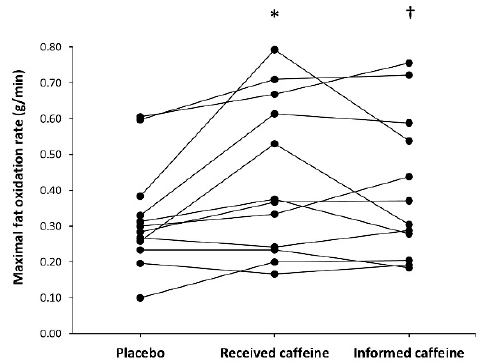
Figure 4. Individual responses for maximal fat oxidation rate during an incremental step exercise test on a cycle ergometer in active individuals who ingested (1) a placebo; (2) three mg of caffeine per kg of body mass (received caffeine); and (3) a placebo, but they were told they were given three mg of caffeine per kg mass (informed caffeine). Each dot represents one participant. (*) Received caffeine different from placebo at p < 0.050. (†) Informed caffeine different from placebo at p < 0.050.